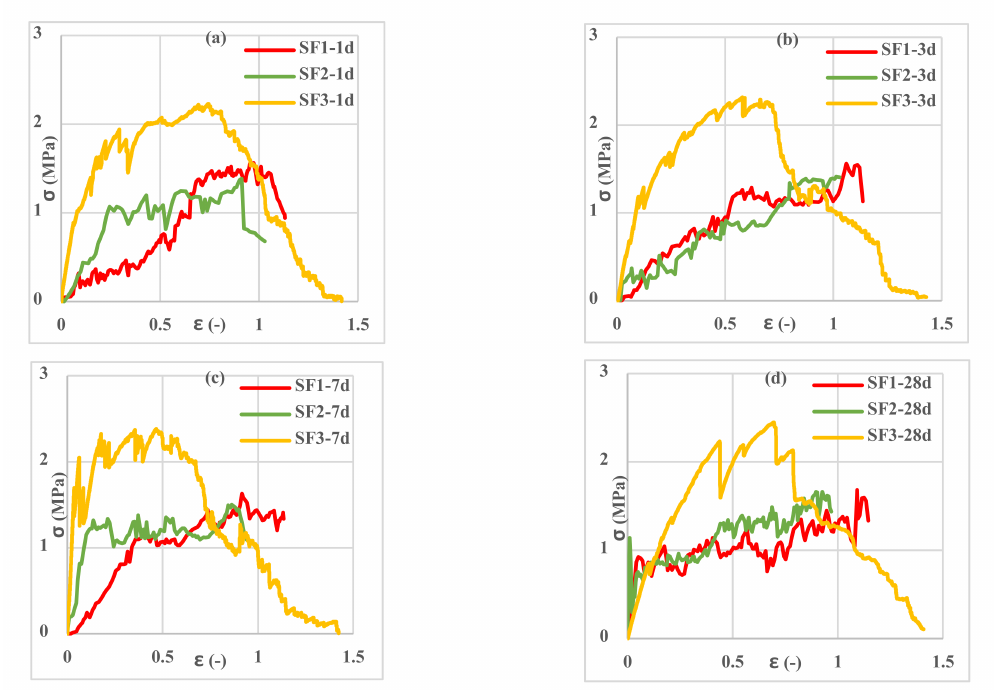
Figure 11. Tensile stress–strain curves of reinforced mortar with 3 types of spacer fabrics in the warp direction cured at 50 ◦ C temperature ( a ) 1 d, ( b ) 3 d, ( c ) 7 d, and ( d ) 28